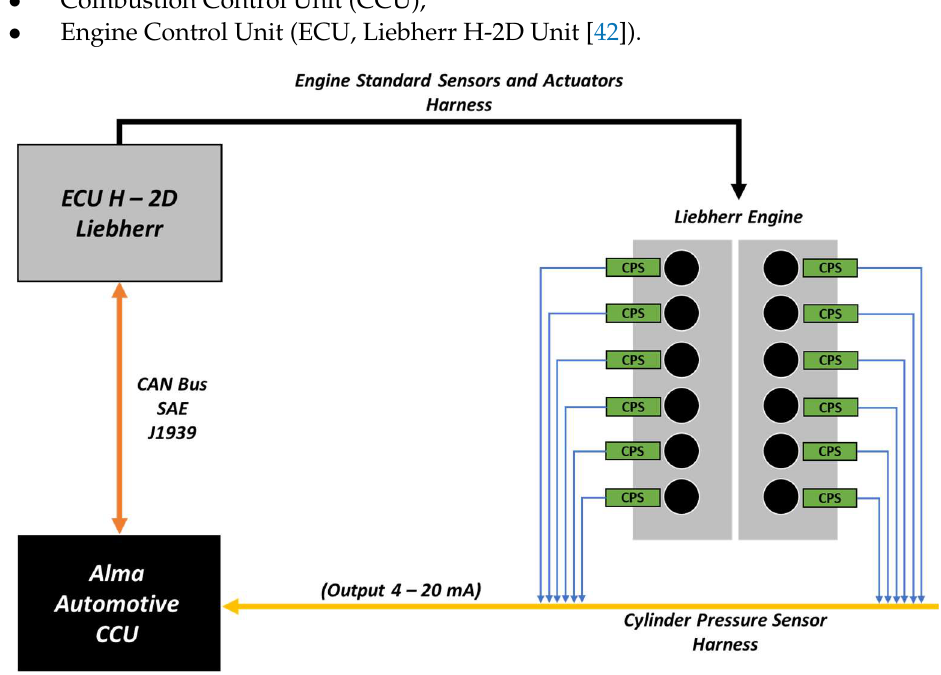
Figure 1. Schematics of the Liebherr Combustion Control Monitoring toolchain (LCCM).